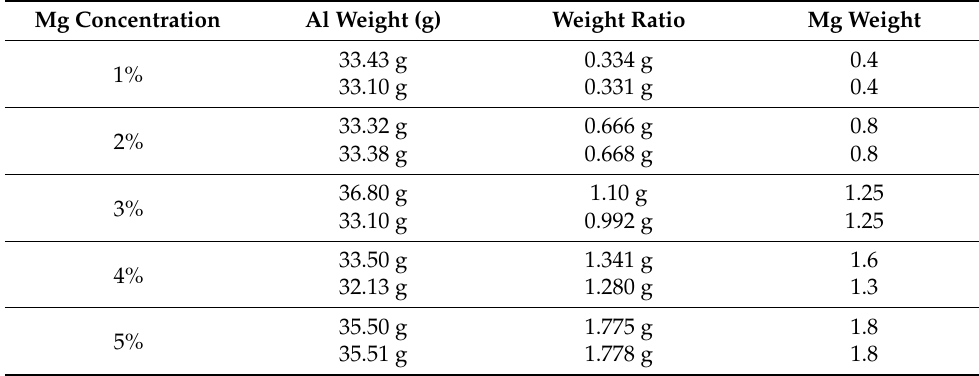
Table 1. Measurement of magnesium percentage concentration based on weight